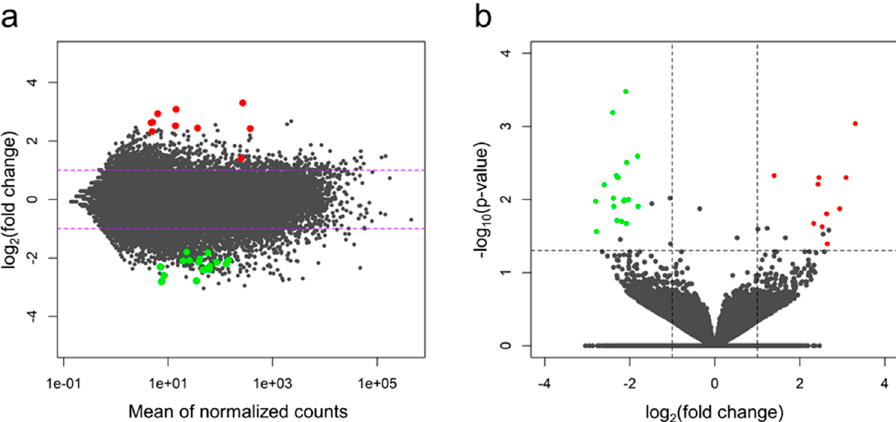
Figure 2. ( A ) MA plot presenting logarithmic values of fold change plotted against normalized counts for IUGR-affected and control libraries. Dotted horizontal lines indicate applied fold change (absolute value of log2FC >1) cut-off. ( B ) Volcano plot showing log2FC plotted against normalized p -values. Dotted horizontal line indicates negative logarithmic adjusted p -value (0.05) cut-off. Dotted vertical lines indicate applied fold change (absolute value of log2FC >1) cut-off. Each point (dot) represents gene expression value; green (underexpressed in IUGR) and red (overexpressed in IUGR) represent the significant DEGs (adjusted p -value < 0.05). Both plots present values (points positions) calculated with the DESeq2 algorithm, green and red points depict DEGs confirmed by both DESEq2 and edgeR methods. Grey dots indicate nonsignificant genes.